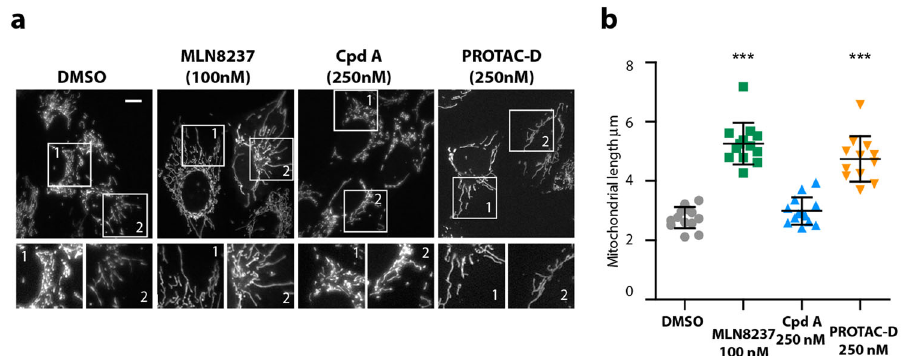
Fig. 7 PROTAC-D treatment restores the mitochondrial network in FZR1 KO cells. U2OS FZR1 KO cells, in which mitochondria are highly fragmented due to the presence of excess AURKA 24 , were treated for 3 h with DMSO or with MLN8237, Cpd A or PROTAC-D at the doses indicated. Cells were then stained with MitoTracker Red TM , imaged and analysed for mitochondrial fragment lengths as described in materials and methods. a Representative images of cells analysed. Scalebar, 10 μ m. b Scatter plots showing mean mitochondrial lengths, mean and SDs under different drug treatments. Each datapoint represents the mean value from 30 mitochondria per cell, n ≥ 12 cells, with results tested for signi fi cance using Mann – Whitney U -test. The data are from a single experiment that is representative of two identical repeats of the same experiment.